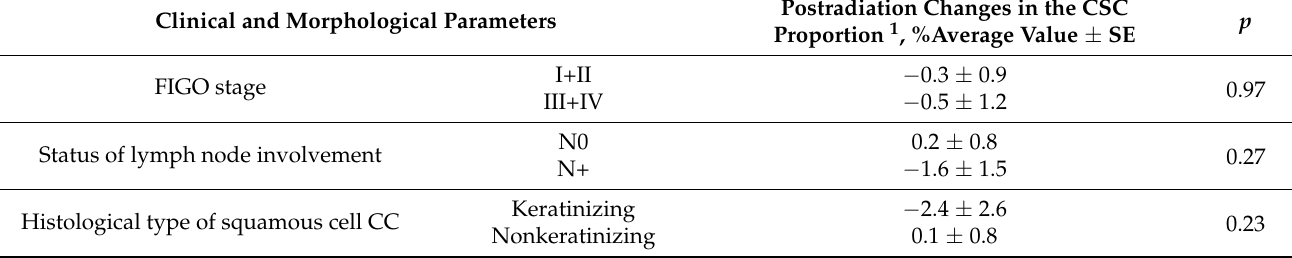
Table 1. Comparison of postradiation changes in the cancer stem cell (CSC) proportion in cervical scrapings from cervical cancer (CC) patients with different clinical and morphological parameters. FIGO, International Federation of Gynecology and